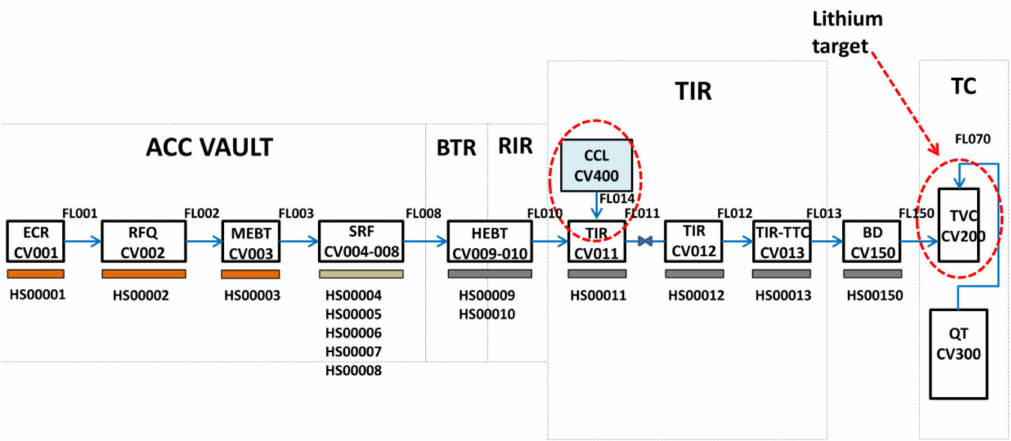
Figure 3. MELCOR models of Lithium Systems (top), Test Systems (middle) and Accelerator Systems (bottom)fordeterministicanalysisofReferenceAccidentScenarios. FLstandsfor(MELCOR)‘FlowPath’, CV for ‘Control Volume’ and HS for ‘Heat Structure’. Then, AC stands for ‘Access Cell’, TS-HCS-MP for ‘Test Systems-Helium Cooling System-Medium Pressure’, TS-HCS-LP for ‘Test Systems-Helium Cooling System-Low Pressure’, TS-GPS for ‘Test Systems-Gas Purification System’, TS-WCS for ‘Test Systems-Water Cooling System’, SS for ‘Stainless Steel’, BTR for ‘Beam Transport Room’, RIR for ‘Radiation Isolation Room’, TIR for ‘Target Interface Room’, TC for ‘Test Cell’, ECR for ‘Electron Cyclotron Resonance’, CCL for ‘Collimator Cooling Loop’, TTC for ‘Target and Test Cell’, BD for ‘Beam Duct’, TVC for ‘Target Vacuum Chamber’, QT for ‘Quench Tank’ (see also acronyms in Figure